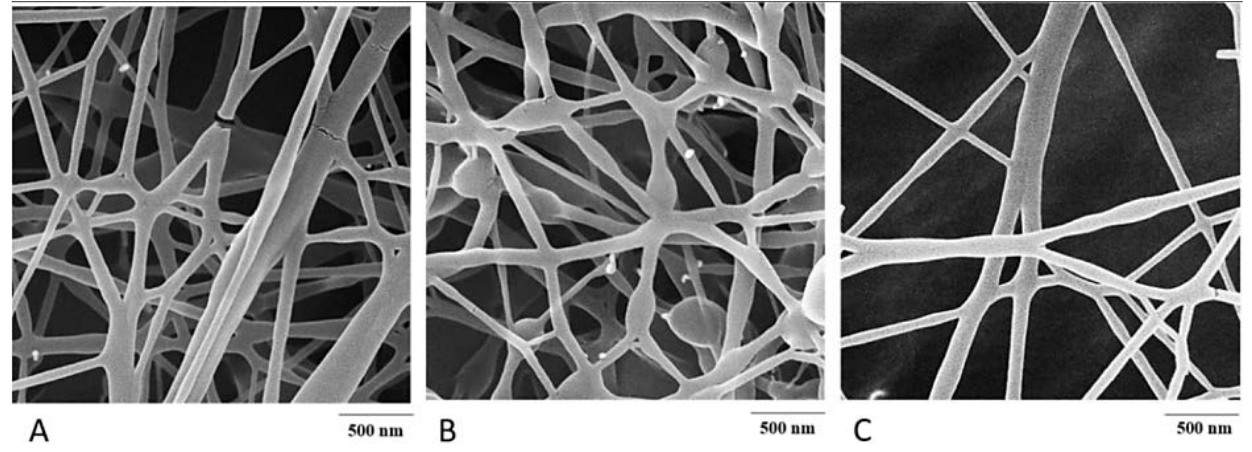
Figure 14 . ERY and tretinoin encapsulated into poly(caprolactone ) fibres. A,B,C codes indicate Figure 14. ERY and tretinoin encapsulated into poly(caprolactone ) fibres. ( A – C ) codes indicate tretinoin concentration of 0.5, 1, and 0 %. Reprinted with permission from [149]. tretinoin concentration of 0.5, 1, and 0%. Reprinted with permission from